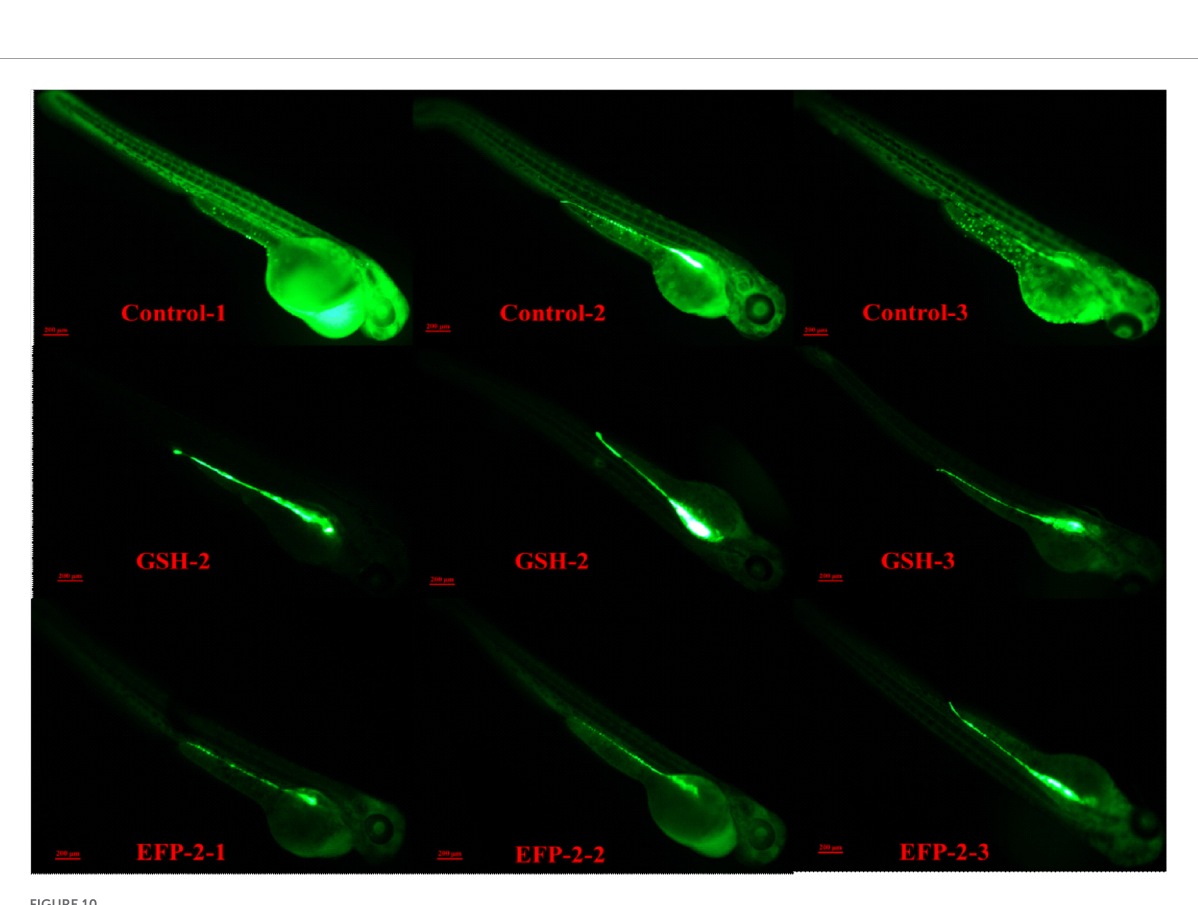
FIGURE10 Partial fluorescence map in